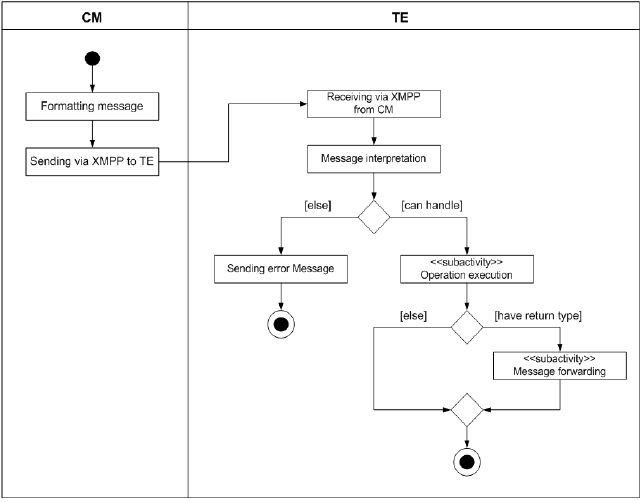
Figure 3. Activity diagram of the external communication.